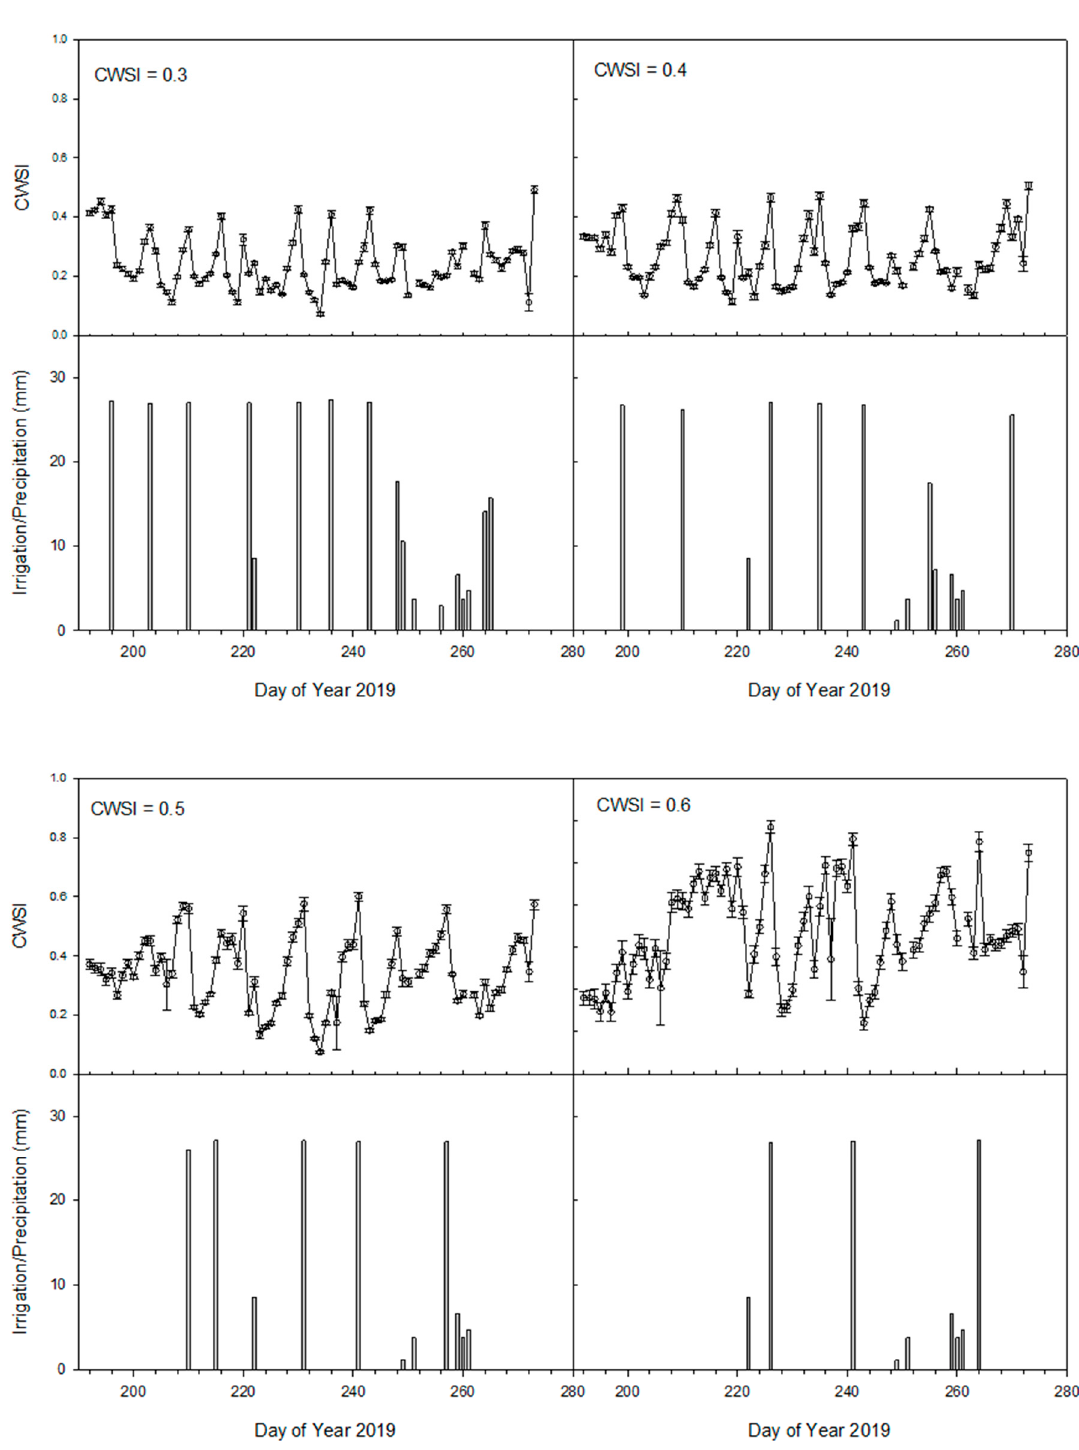
Figure 3. Crop water stress index ( CWSI ), fraction available soil water, and irrigation applications to treatments in 2019. Bars represent ± standard error of the value.